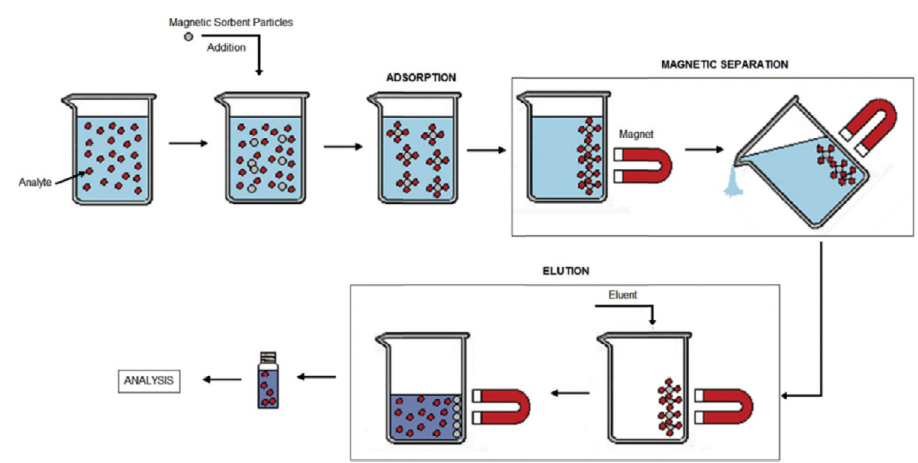
Fig. 1. Schematic presentation of magnetic solid phase extraction (MSPE) [4]